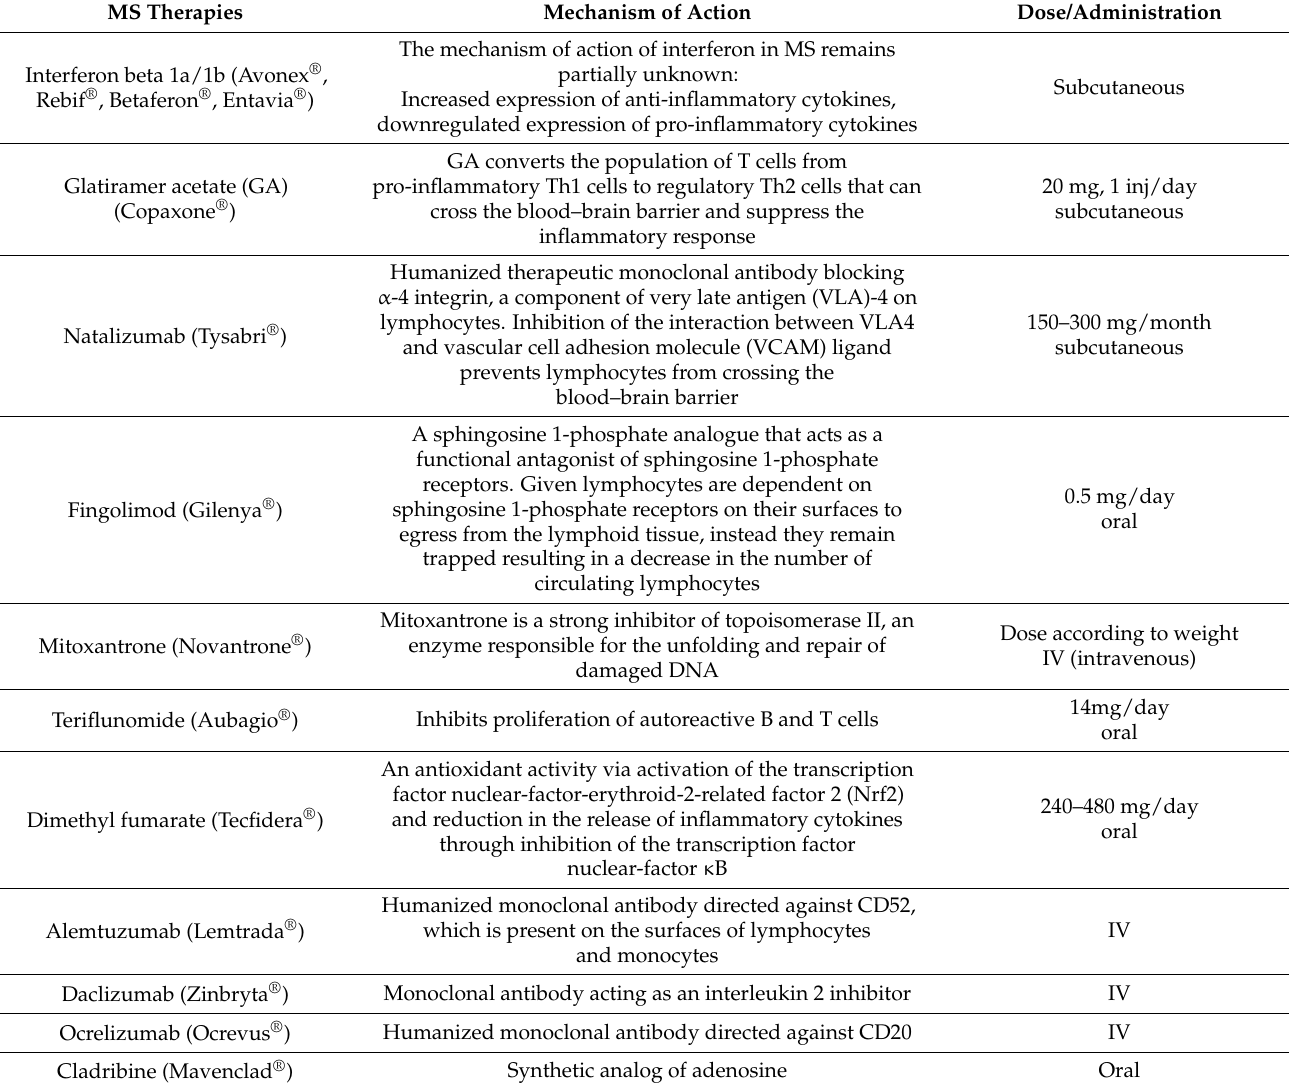
Table 1. MS therapies